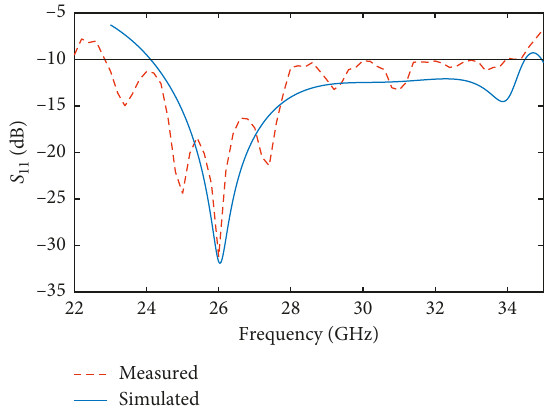
Figure 14: Simulated and measured S